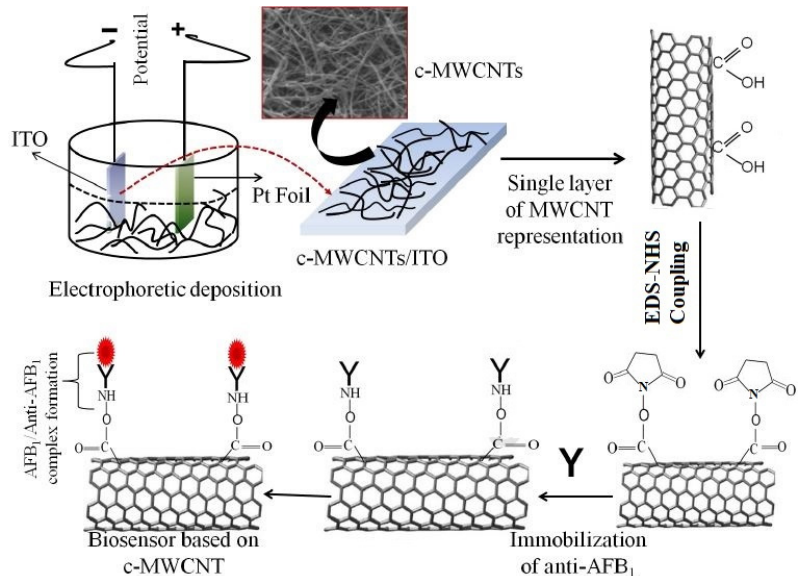
Figure 1. Schematic diagram of the experimental process of detecting AFB1 molecules using carboxyl group functionalized-MWCNTs [104]. Reproduced from Singh, C., Srivastava, S., Ali, M.A., Gupta, T.K., Sumana, G., Srivastava, A., Mathur, R.B. and Malhotra, B.D., 2013. Carboxylated mul- tiwalled carbon nanotubes based biosensor for aflatoxin detection. Sensors and Actuators B: Chemi- cal , 185 , pp. 258–264.